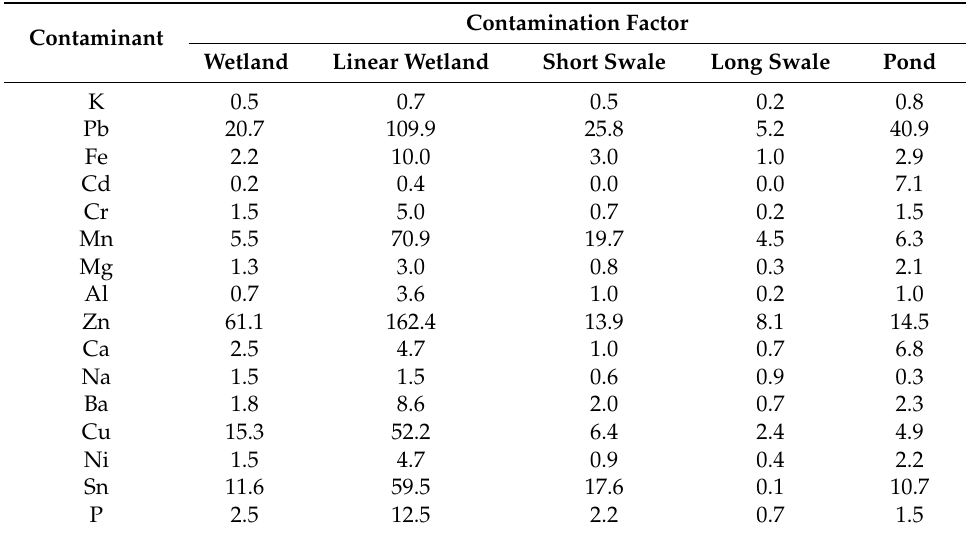
Table 8. Average Contamination Factors for each SuDS asset and